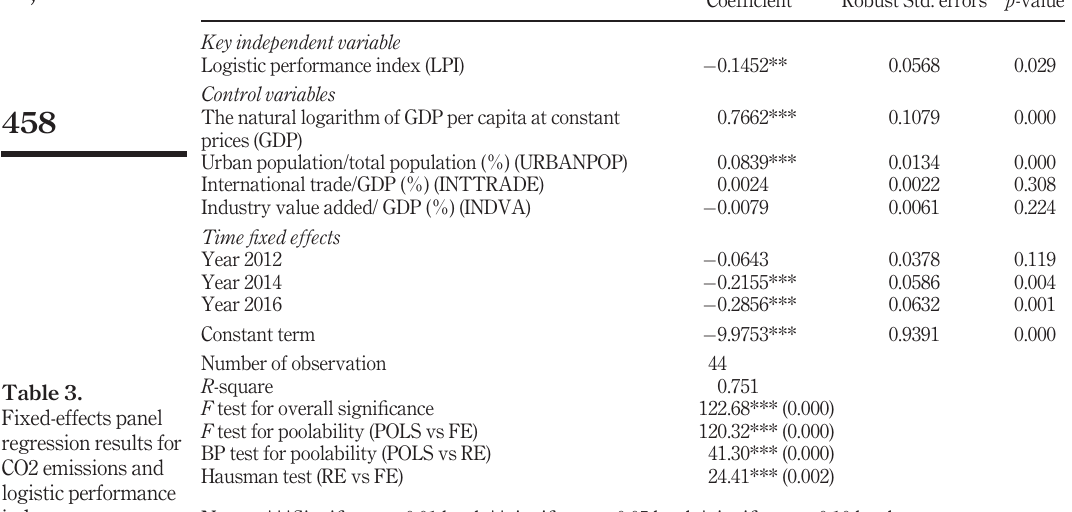
Table 3. Fixed-effects panel regression results for CO2 emissions